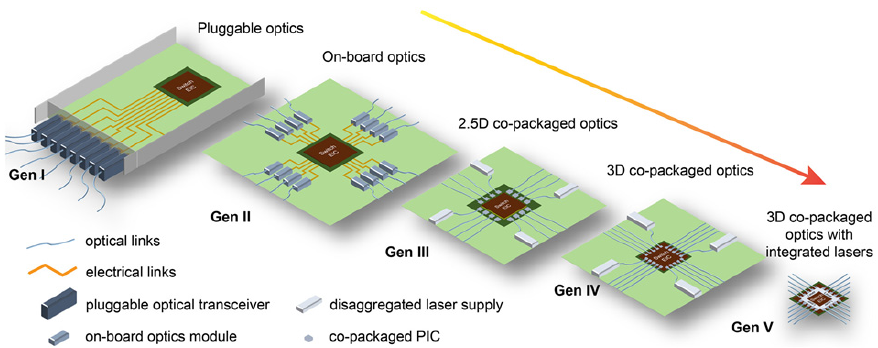
Figure 1. Generations of optics and the evolution of co-packaging technologies used in data center applications.